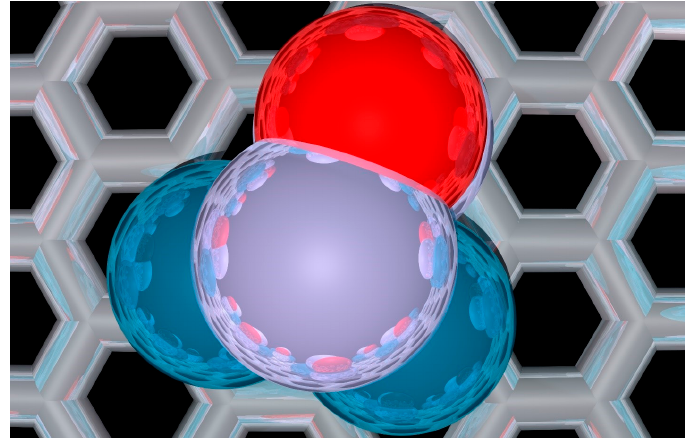
Figure 1. Representative top-down view of a 4 atom metal-decorated graphene (MDG) nanoparticles (NP) as studied in this work. Specifically in this figure, O* adsorbed on Pd 2 Pt 2 is shown. Pd in dark blue, Pt in lavender, Graphene in silver, and Oxygen in red. For full details of candidate structure, reproduced from [5], with permission of Elsevier, 2018.